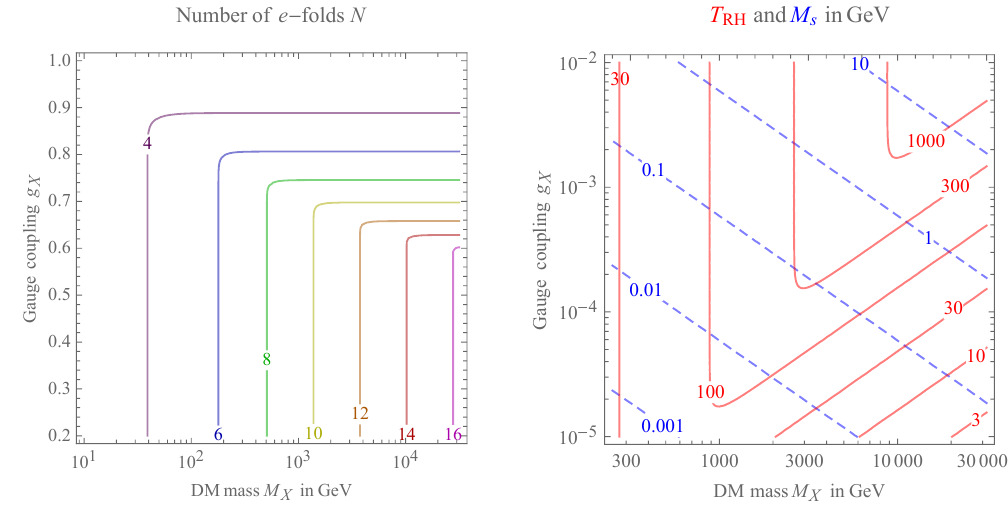
Figure 2 . Left: number of e -folds of thermal in(cid:13)ation, N = ln T in(cid:13) =T end for h h i QCD = 100 MeV. Right: reheating temperature in GeV (solid red curves) and M s = GeV (diagonal dashed lines). contours corresponds to end of super-cooling via vacuum decay, and the vertical part to the QCD-triggered